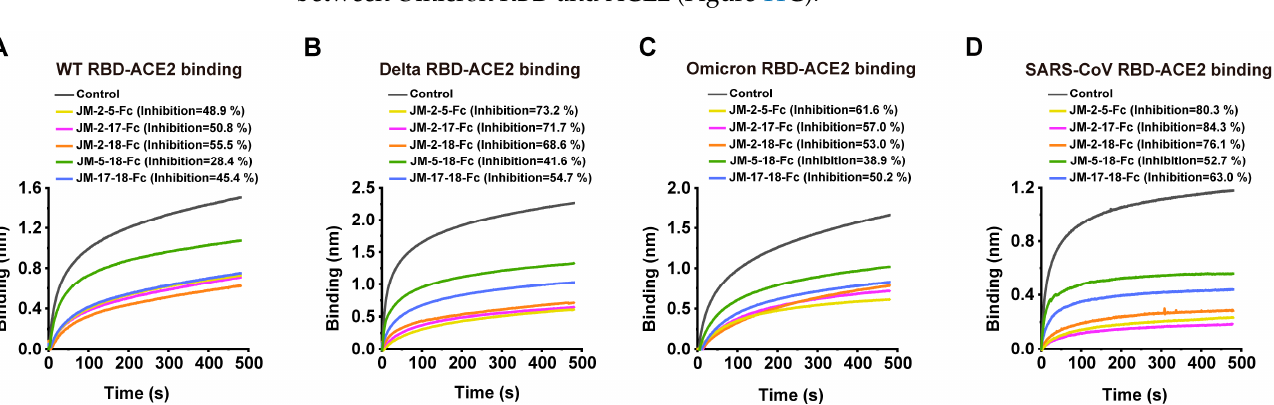
Figure 11. RBD-ACE2 blocking activities of bi-paratopic VNARs characterized by BLI assay. ( A – D ) Blocking of ACE2 binding to the RBDs of WT, Delta, Omicron, and SARS-CoV by bi-paratopic VNARs. SA biosensors were loaded with biotinylated RBD, then incubated with bi-paratopic VNAR-Fc fusion and ACE2 sequentially. Bi-paratopic VNAR was replaced with PBST and used as a control. The inhibition rates of bi-paratopic VNARs were calculated against the control group.